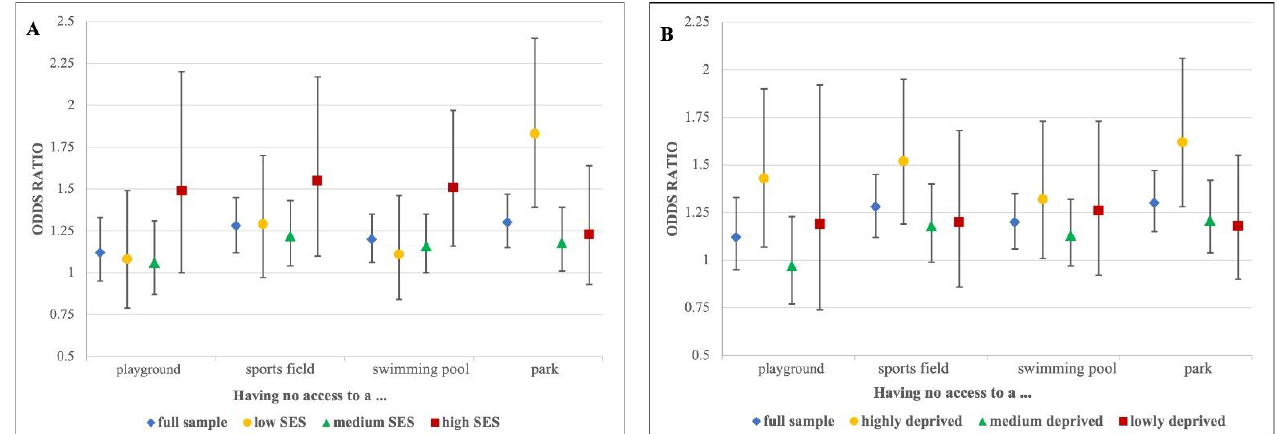
Figure 1. Odds ratios and 95% confidence intervals for total difficulties in children and adolescents who have no access to selected social infrastructure places compared to those with access: ( A ) stratification by socioeconomic status (SES); ( B ) stratification by municipal socioeconomic deprivation.